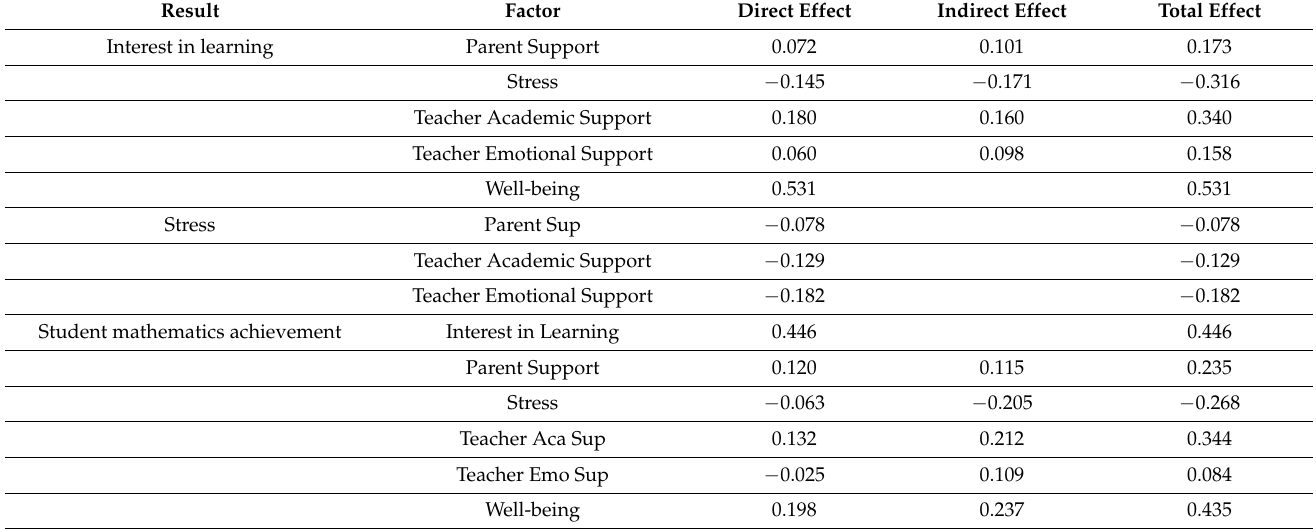
Table 9. The direct, indirect, and total effect of the research